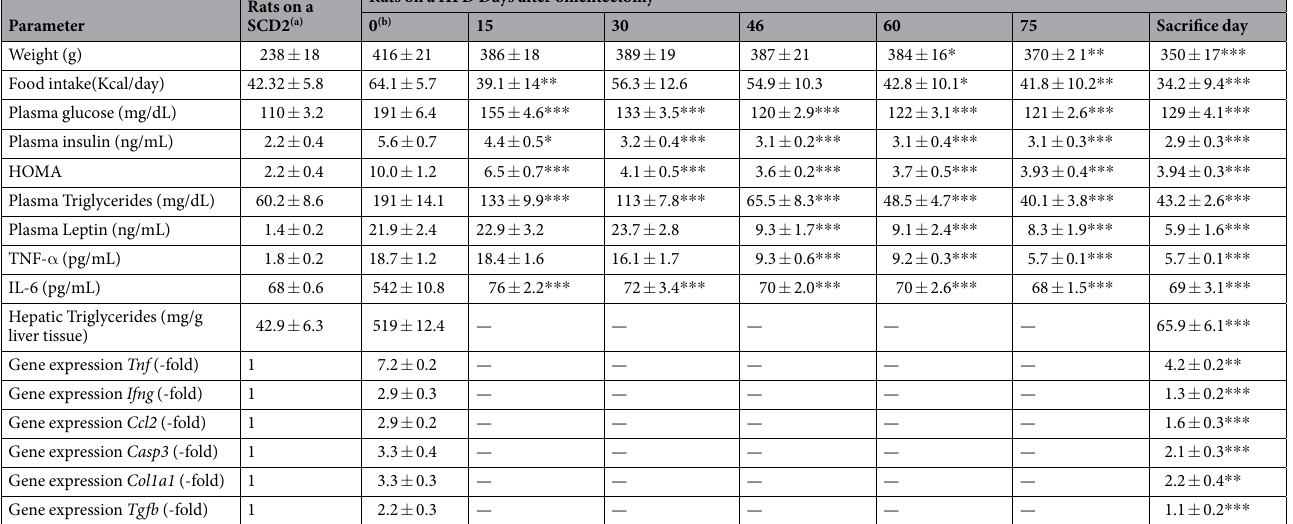
Table 2. Evolution of some variables following omentectomy in obese rats on a HFD. (a) After two months on a SCD; (b) after two months on a HFD; Results are given as mean ± S.D., * p < 0.05; ** p < 0.01; *** p < 0.001 vs . day 0 of omentectomy. –fold, change above gene expression in rats on a SCD.